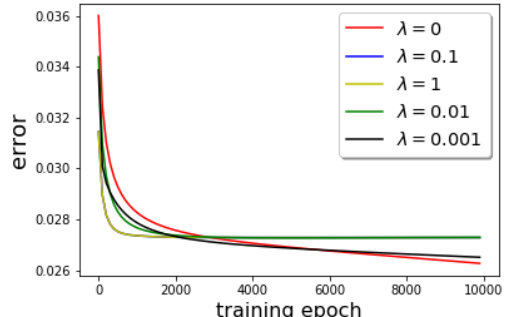
Figure 7. Validation error performance for different values of the regularization parameter λ .